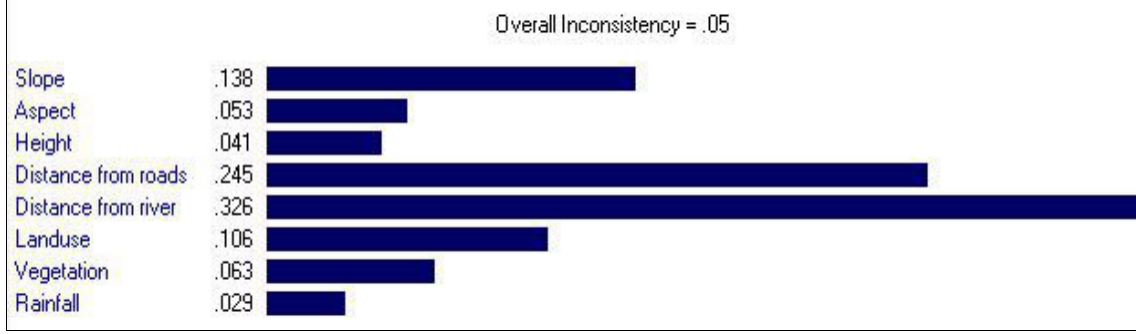
Figure 4. Weight of criteria used in Fuzzy-AHP model for preparation of landslide hazard mapping using AHP